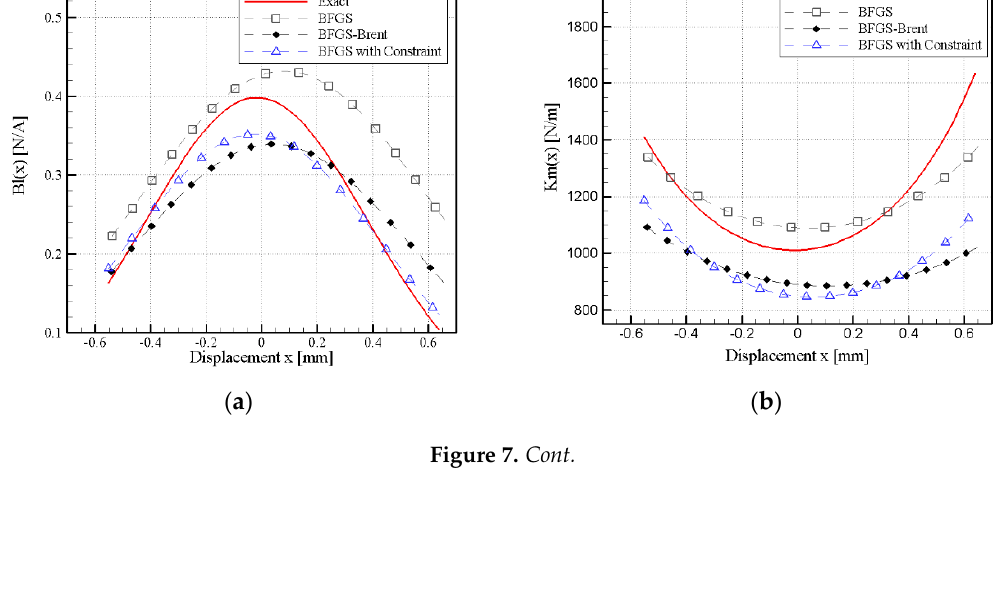
Figure 6. Effect of measurement error σ = 0.05 on nonlinear parameters, ( a ) Bl ( x ), ( b ) K m ( x ), ( c ) L e ( x ), and ( d ) R m ( x ).